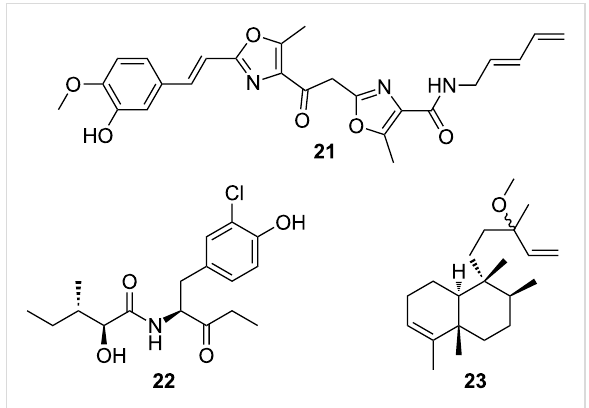
Figure 6: Structures of natural products isolated from Herpetosiphon spp.: siphonazole ( 21 ); auriculamide ( 22 ); (+)- O -methylkolavelool ( 23 ).